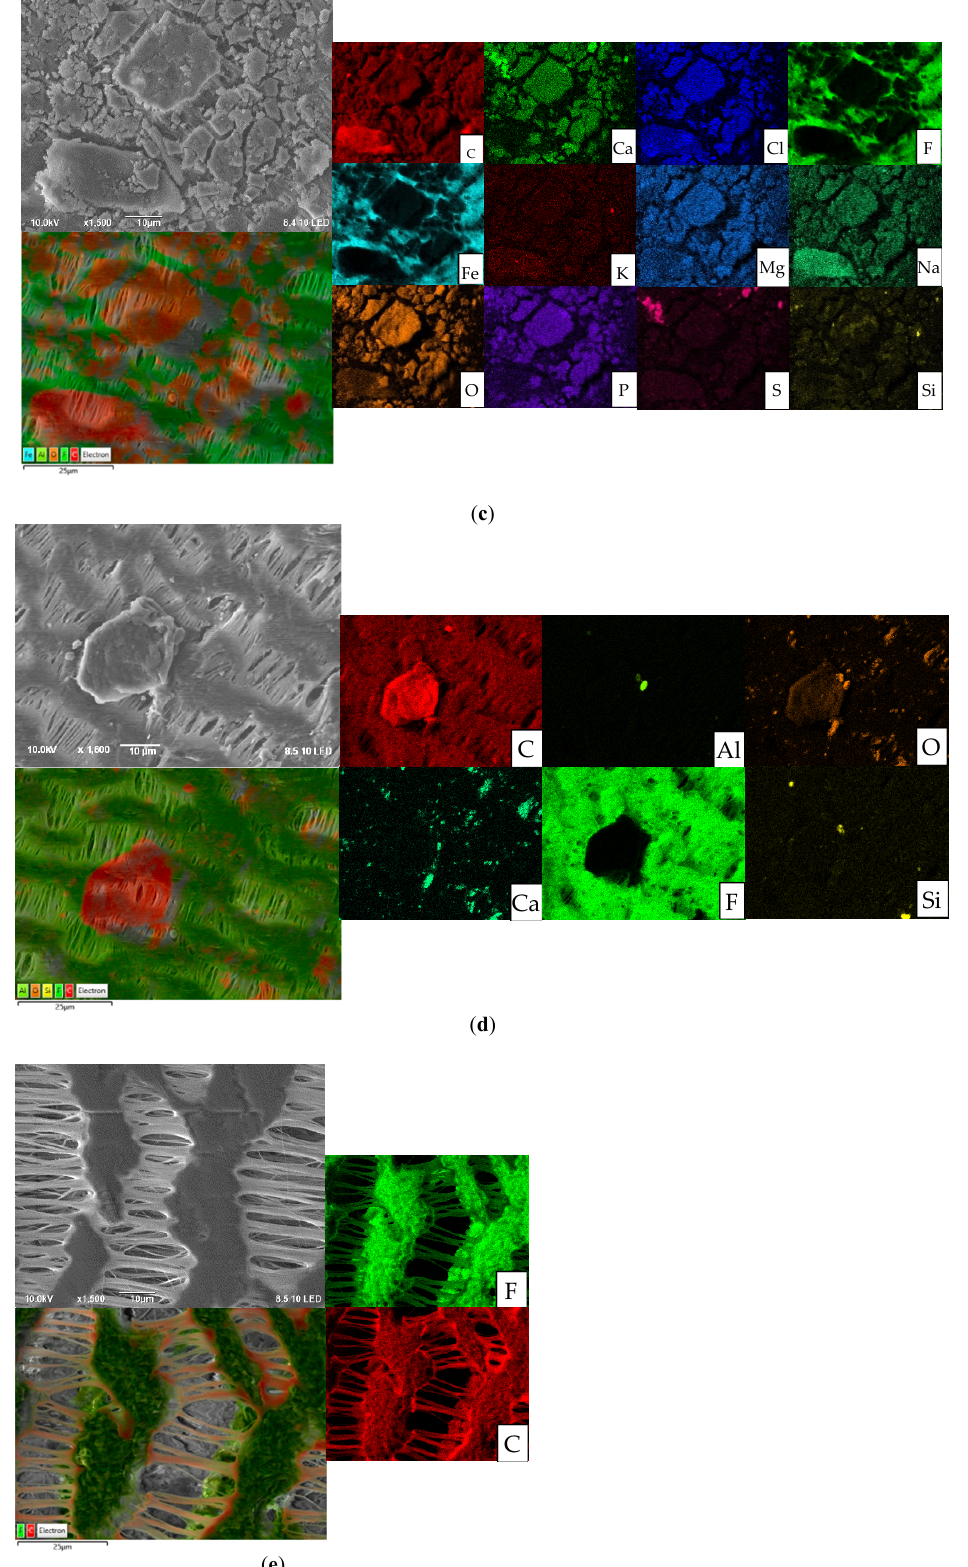
Figure 7. SEM-EDS maps for ( a ) virgin membrane, ( b ) fouled membrane from lab-scale experiment, ( c ) fouled membrane from pilot run, ( d ) fouled membrane of leachate treated with tannins, and ( e ) fouled membrane with untreated leachate after UV+H 2 O 2 cleaning.